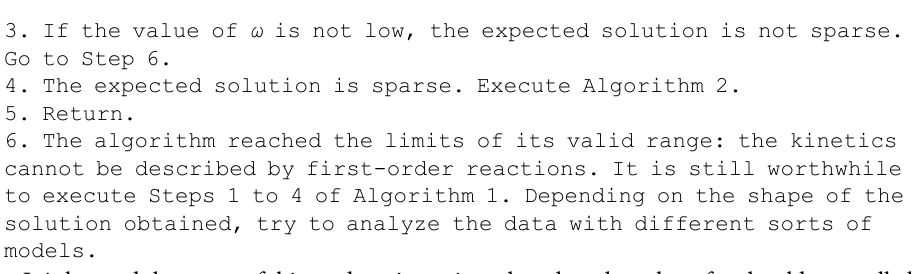
Fig 8. The kinetics corresponding to the distributions presented in S2 Fig (blue). For comparison see the kinetics corresponding to the single discrete value at the maximum (200) of the activation energy distribution (red).